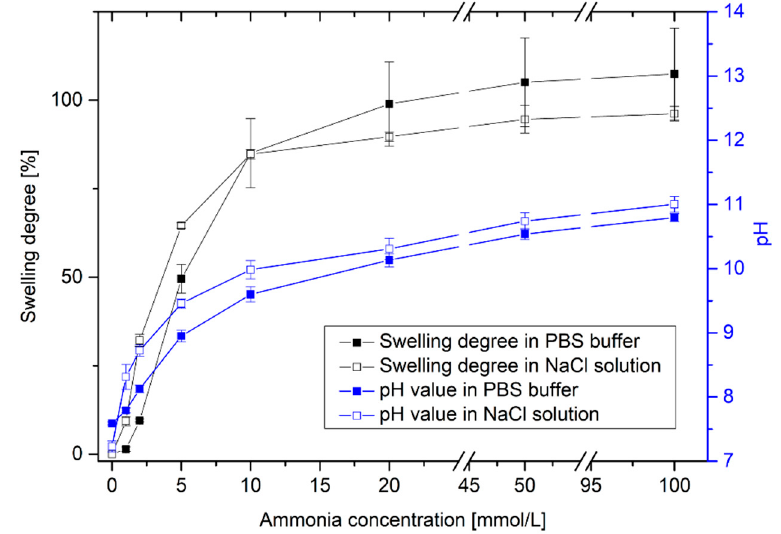
Figure 4. Swelling behavior of poly(AAc- co -DMAEMA) (60 mol% AAc, 40 mol% DMAEMA) hydrogels and resulting pH value for different ammonia concentrations in PBS buffer and isotonic saline solutions (NaCl).